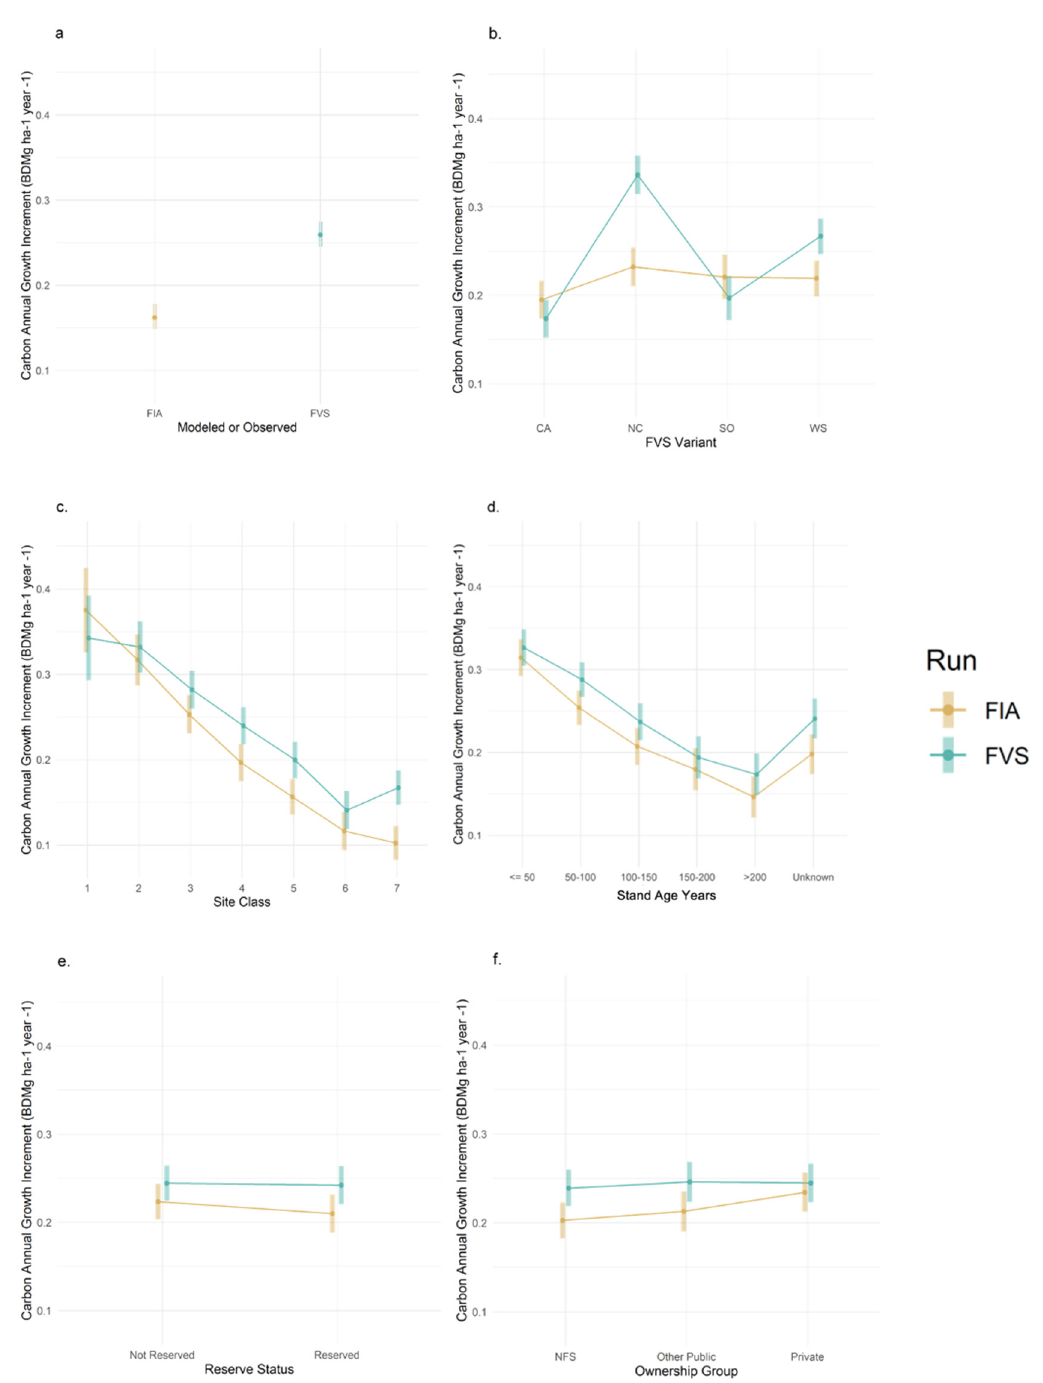
Figure 4. Average effect for the run (FIA vs. FVS) variable ( a ) and interaction terms ( b – f ), showing the relative effect of each level of each interaction term on the modeled FIA and FVS means for those levels, illustrating where FVS predictions over- and under-state modeled FIA values. FVS Variants ( b ) include Southern Cascades (CA), Klamath Mountains (NC), South Central Oregon and Northeast California (SO), and Western Sierra Nevada (WS).